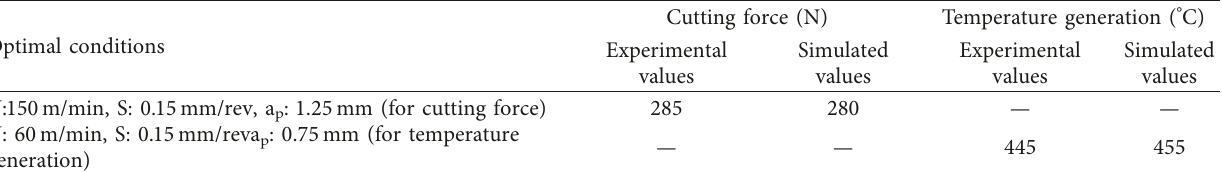
Table 9: Optimum factors and machining characteristics: confirmation by simulation.